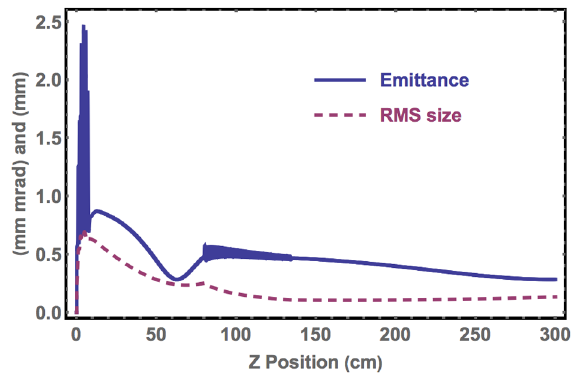
FIG. 9. PARMELA simulation results for the Mark 1 X-band rf gun and a single T53 accelerator section: normalized transverse emittance in solid blue and RMS beam size in dashed red as a function of Z position.